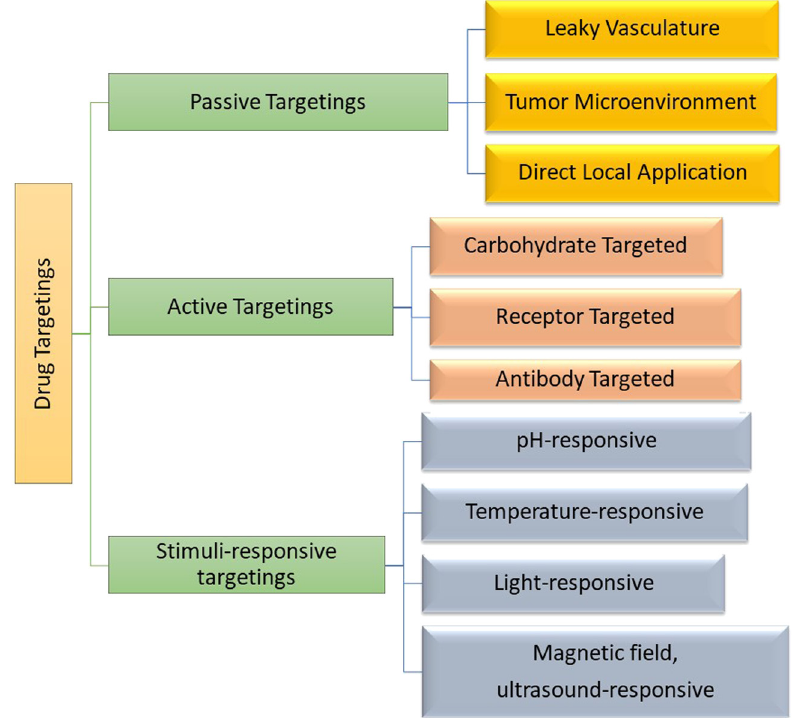
Figure 10: Di ff erent types of drug targetings.